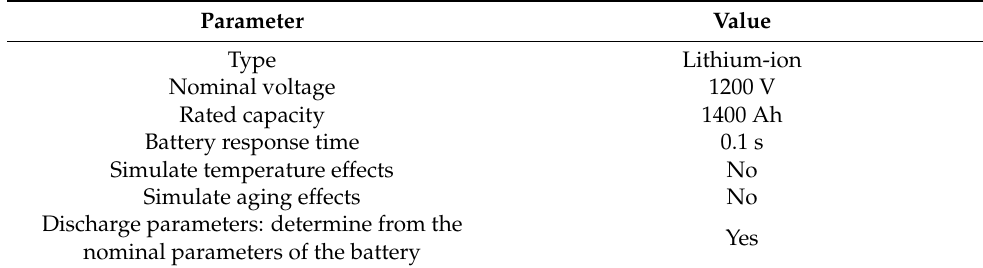
Table 3. Parameters of the battery in Simulink.